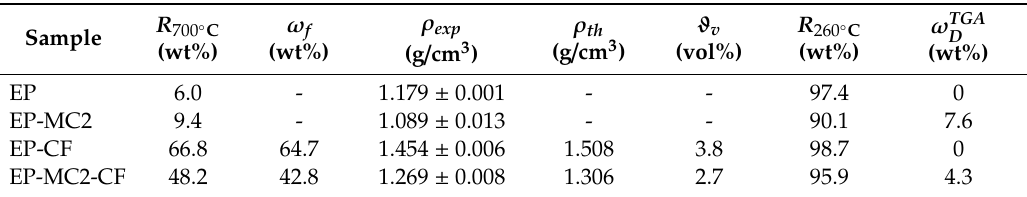
Table 4. Density and weight fraction of the constituents of the epoxy-based matrices and laminates from the TGA and Archimedes’ balance tests.